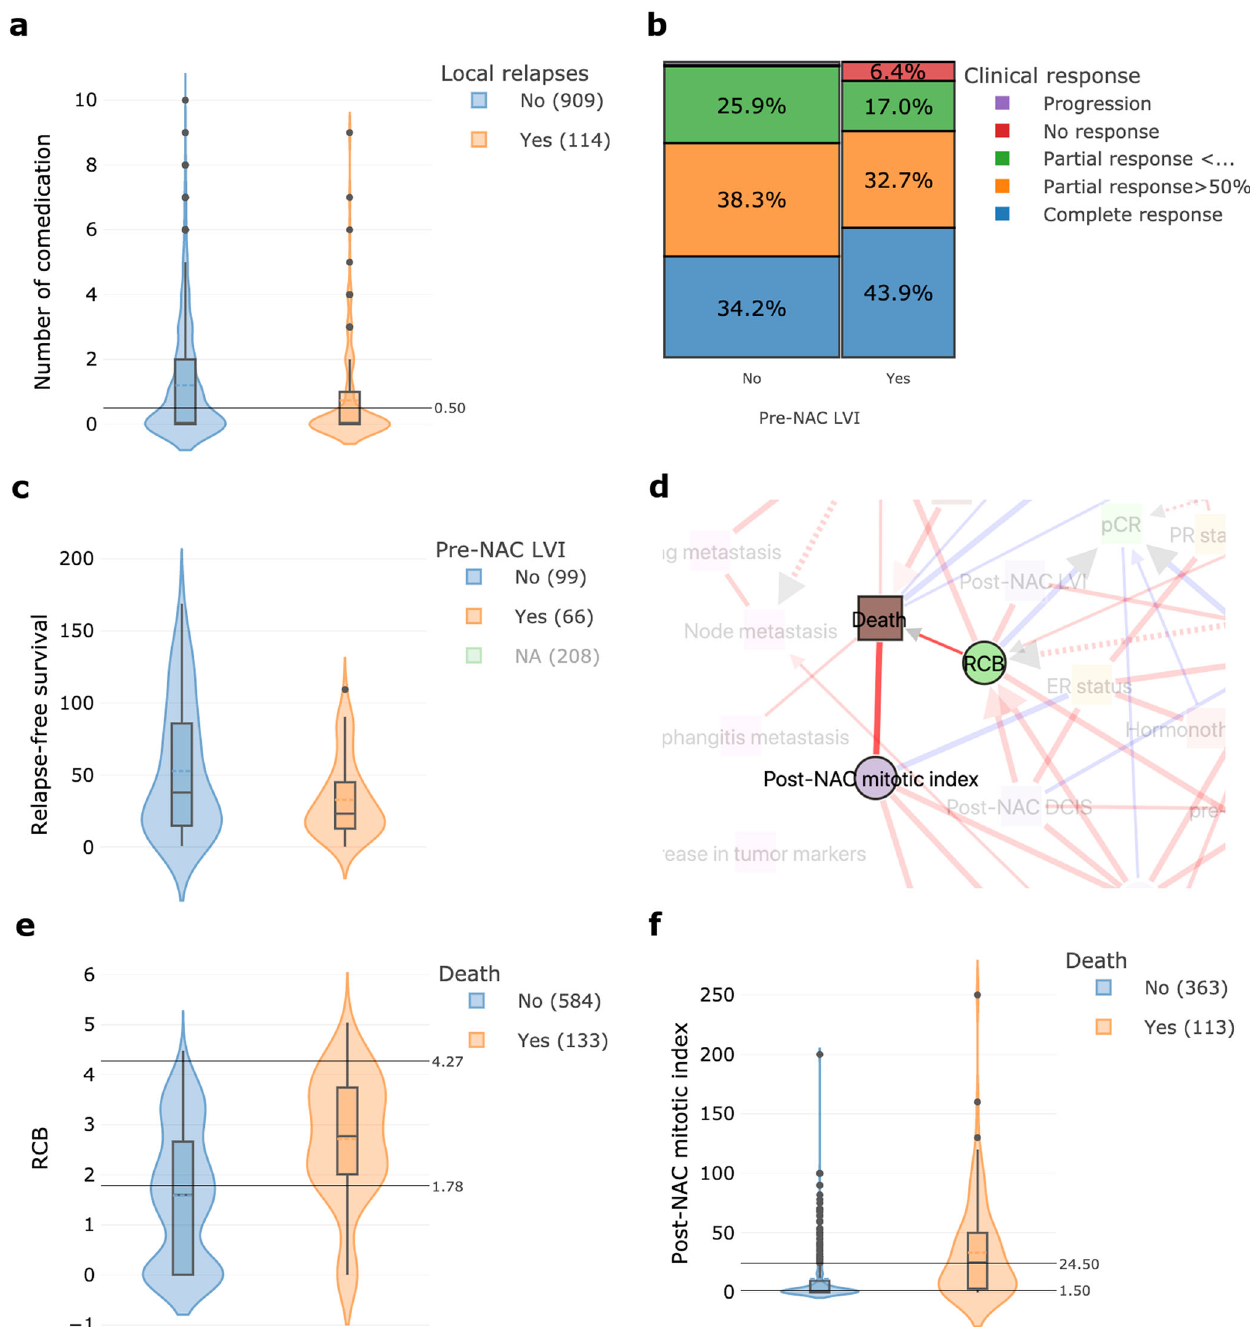
Fig. 5 MIIC identi fi es factors likely to improve prediction or prognosis. a Network interaction displaying the link between local relapse occurrence and the number of drugs taken (comedication). b Proportion plot showing the percentage of different clinical responses according to the presence or absence of pre-NAC lymphovascular invasion. c Boxplot of relapse-free survival according to the presence or absence of pre-NAC lymphovascular invasion. d Network interaction displaying the link between death, RCB and post-NAC mitotic index. e Boxplot of RCB values according to vital status. f Boxplot of post-NAC mitotic index according to vital status. The boxes represent the IQR, the horizontal lines correspond to the median values and lines ends mark the upper and lower fence. The number of cases considered for the analysis are reported in the